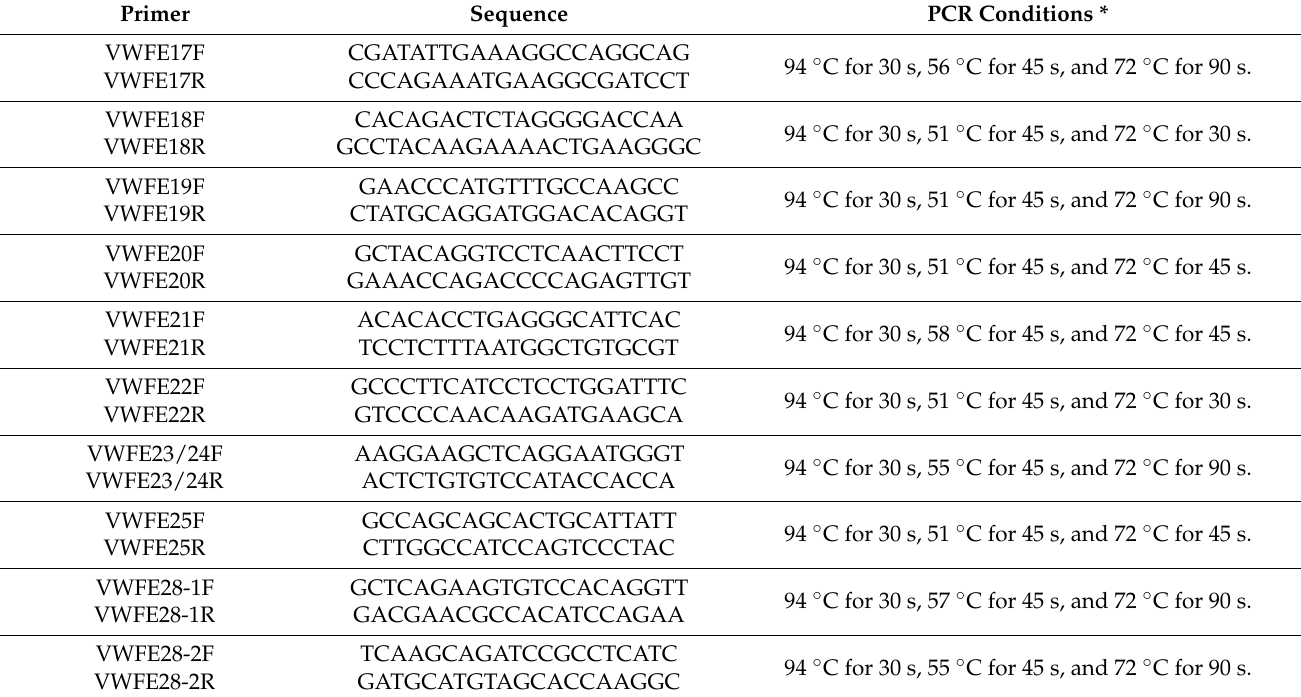
Table 1. Primer sequences used in PCR amplifications of the F9 and VWF genes with the different PCR conditions for each primer pair. Sequence PCR Conditions